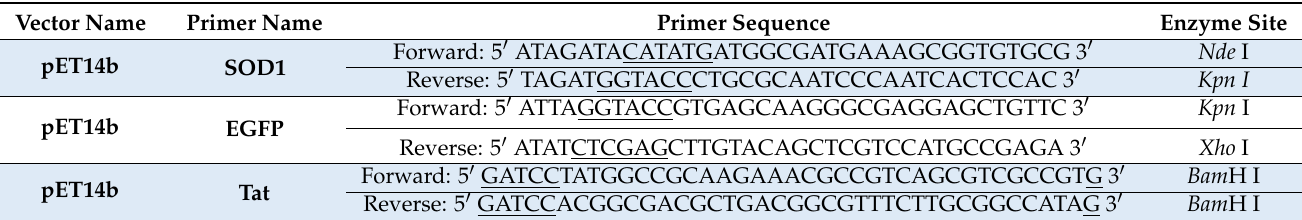
Table 1. Detailed information of primers used for the construction of recombinant plasmids expressing SOD1, SOD1-Tat, SOD1-EGFP, or